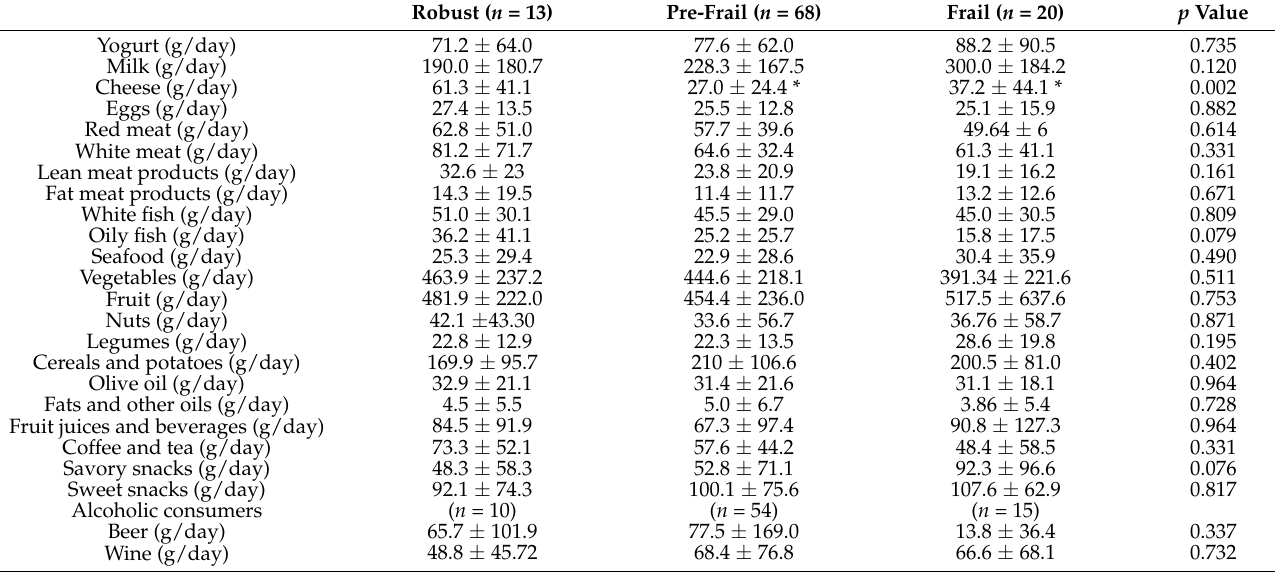
Table 2. Differences of food group intakes between robust, pre-frail, and frail older